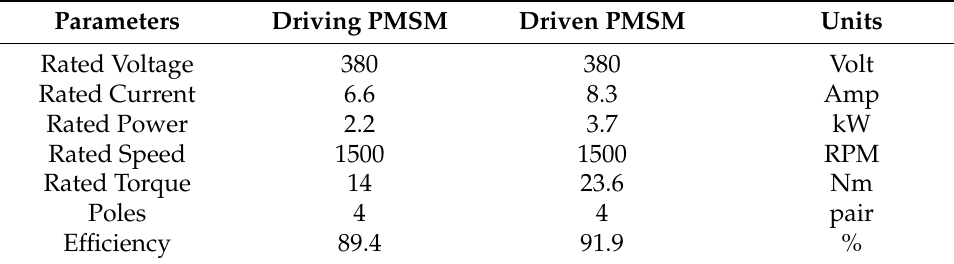
Figure 4. PMSM load experimental platform. Table 2. Driving and driven PMSM rated